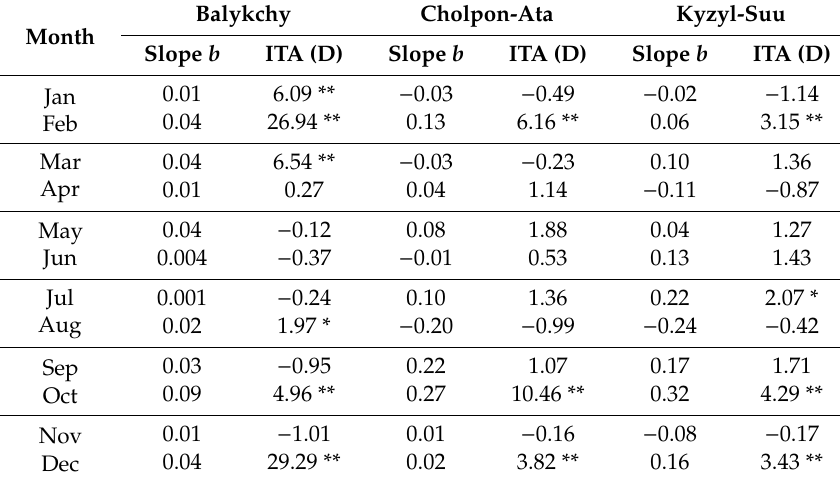
Table 4. The values of the linear regression slope and D of ITA for monthly precipitation in the Lake Issyk-Kul basin from 1951 to 2012. Balykchy Month